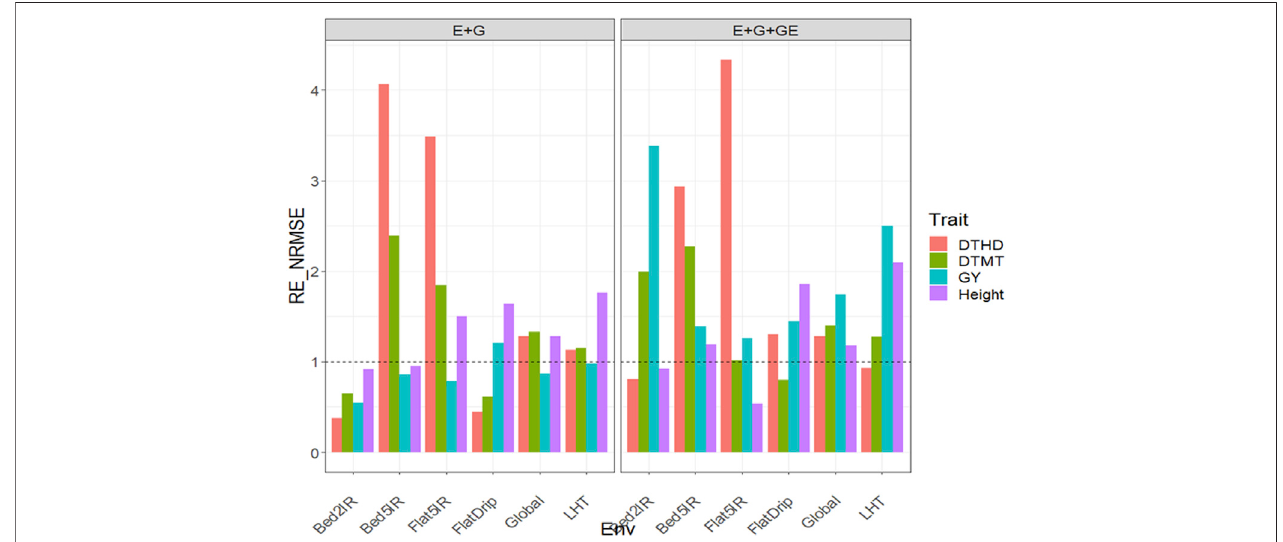
FIGURE 3 | Relative ef fi ciency in terms of normalized root mean square error (RE_NRMSE) computed by dividing the NRMSE under the best linear unbiased predictor model (GBLUP) between the NRMSE of the partial least squares regression method. Prediction performance is reported for each environment and across environments(Global)indataset3(EYT_3),alsowithtwopredictors(E+GandE+G+GE).WhentheRE_NRMSE > 1,thePLSoutperformstheGBLUPmethodinterms of prediction performance (lower NRMSE).